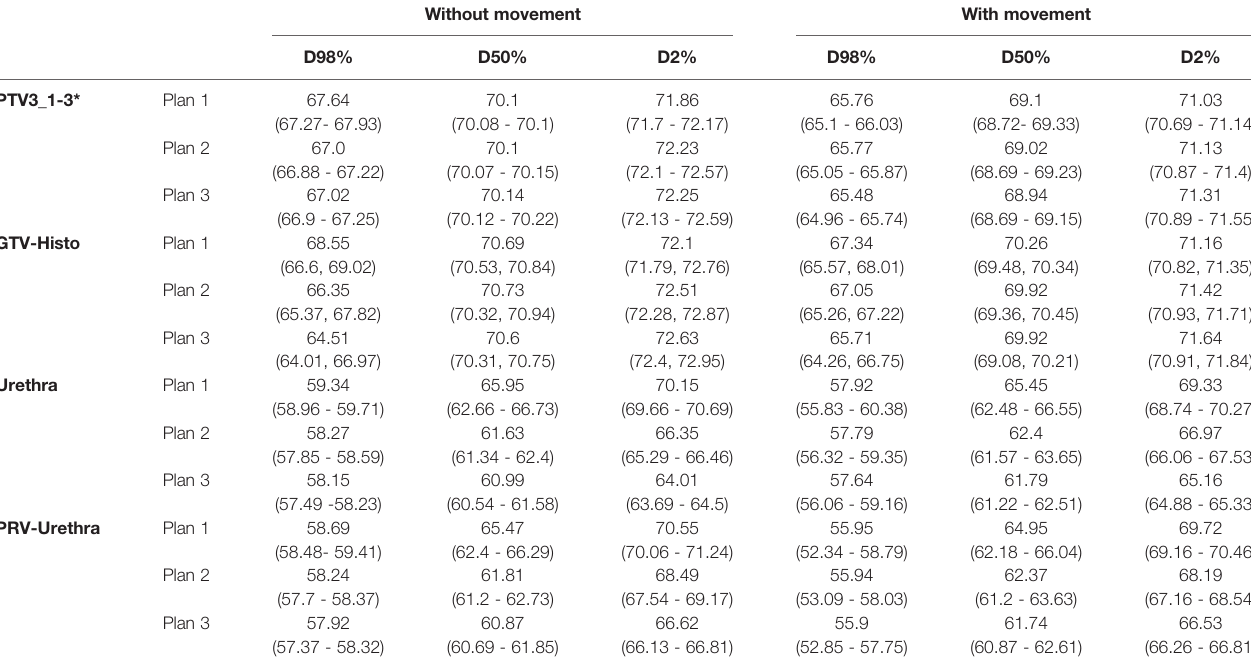
TABLE 3 | Dose volume parameter values for different volumes without and with consideration of prostate intrafractional movement. Without movement With